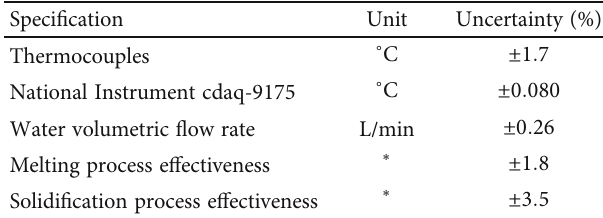
Table 2: Parameter of